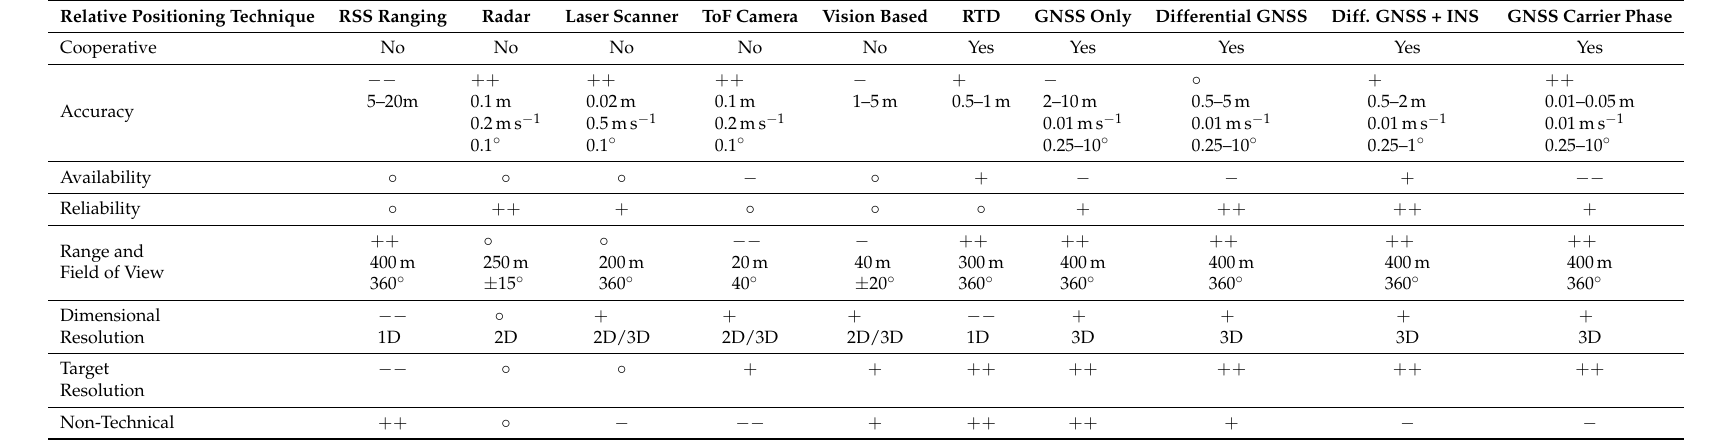
Table 4. Relative positioning